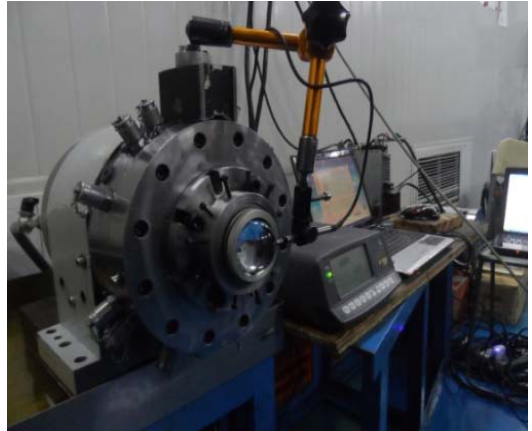
Figure 7. Spindle rotation accuracy detection.